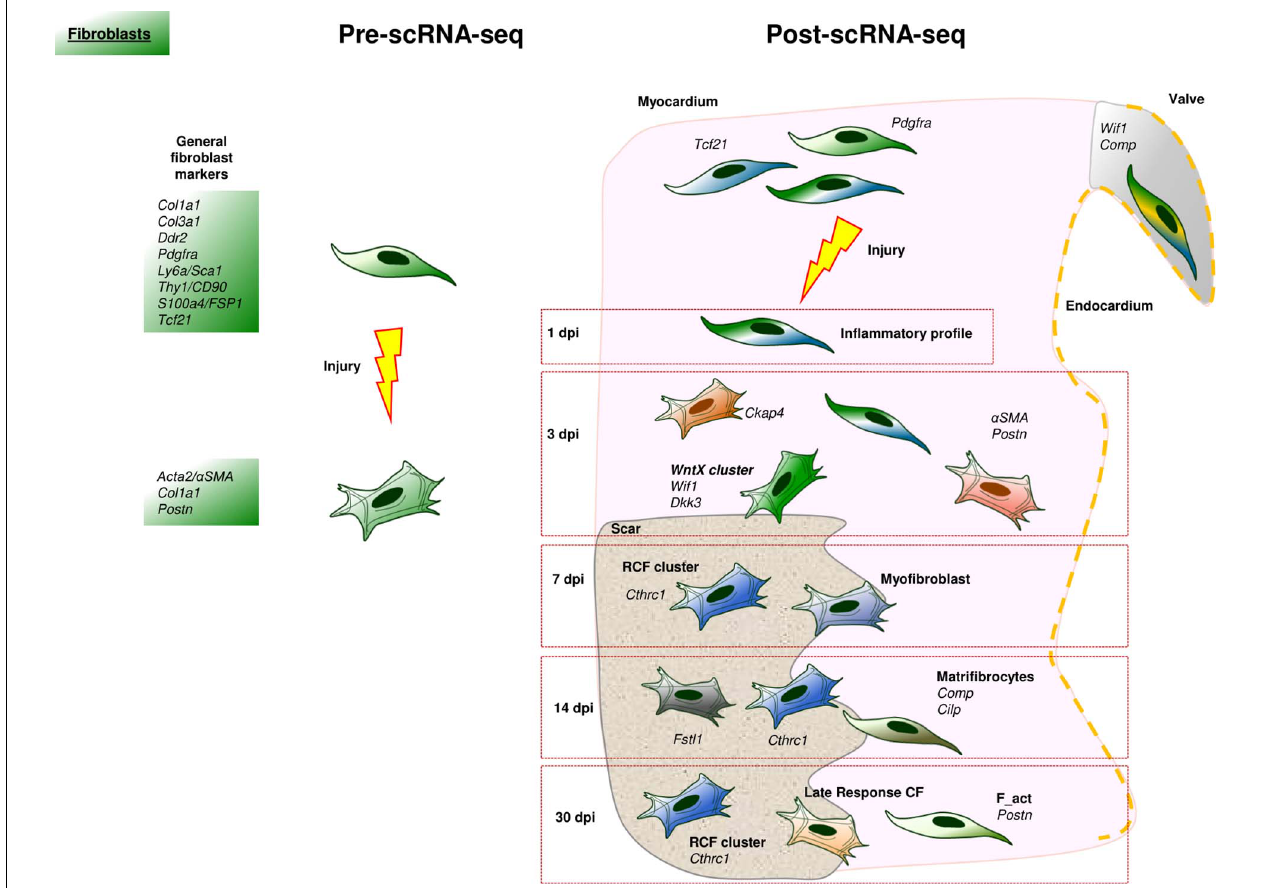
FIGURE 3 | Cardiac fibroblast landscape before and after scRNA-Seq. In the scRNA-Seq part, each cell represents an identified subpopulation of cardiac fibroblasts characterized by a specific transcriptomic signature. Some of these populations have been named after the original study that identified